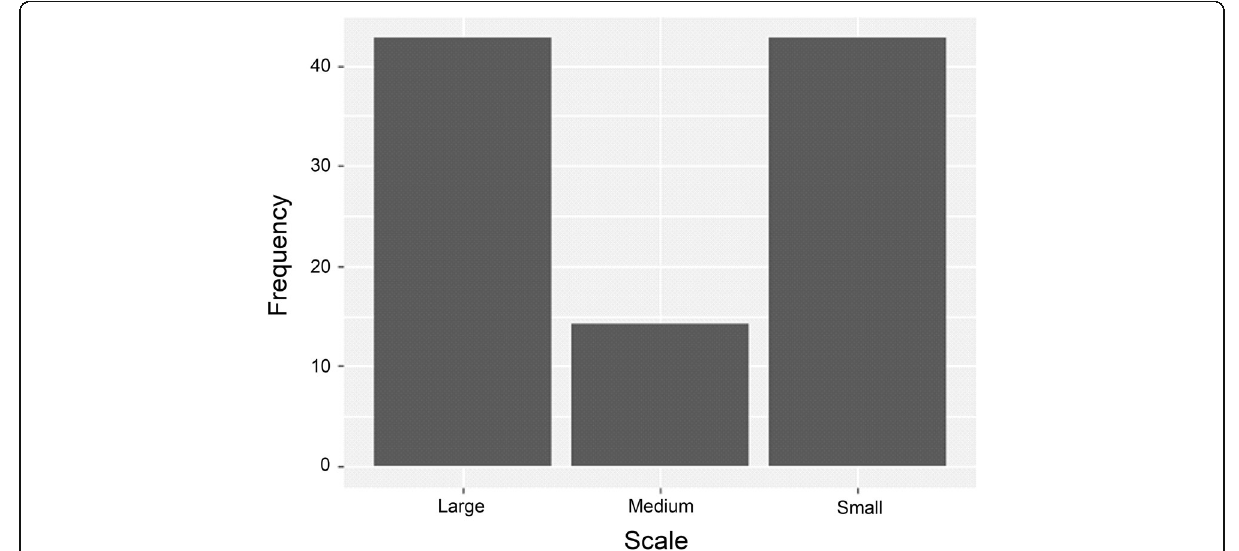
Fig. 2 Frequency of selected scales (in meters) across all variables for the random forest